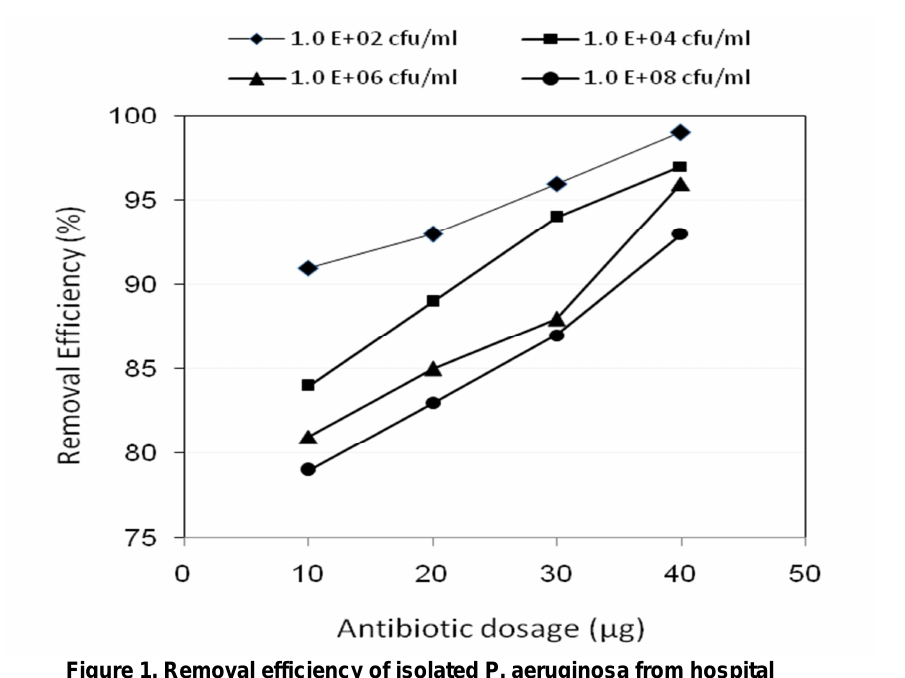
Figure 1. Removal efficiency of isolated P. aeruginosa from hospital